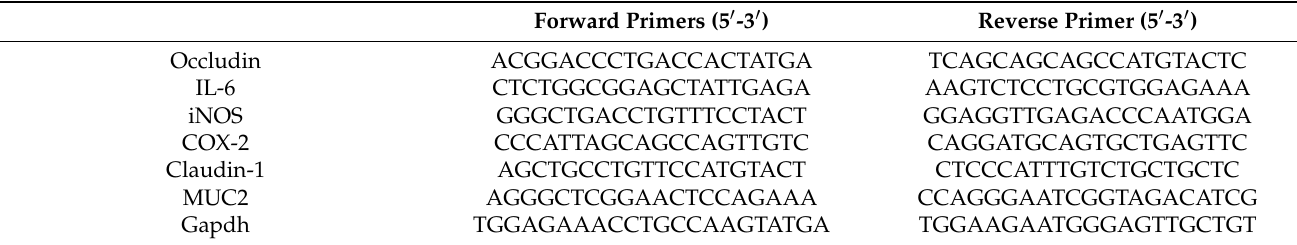
Table 1. Primer sequences used for qRT-PCR